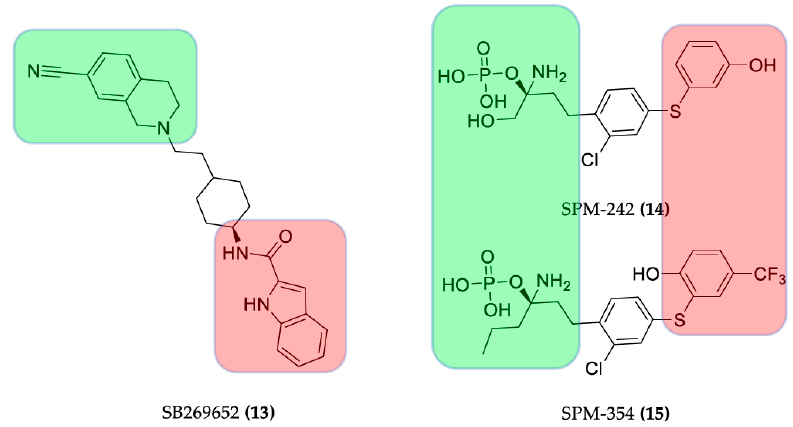
Figure 8. Structures of bitopic hybrids. 13 D3 dopaminergic ligand SB269652; 14 , 15 bitopic S1P3 antagonist. Orthosteric building block in green allosteric building block in red.